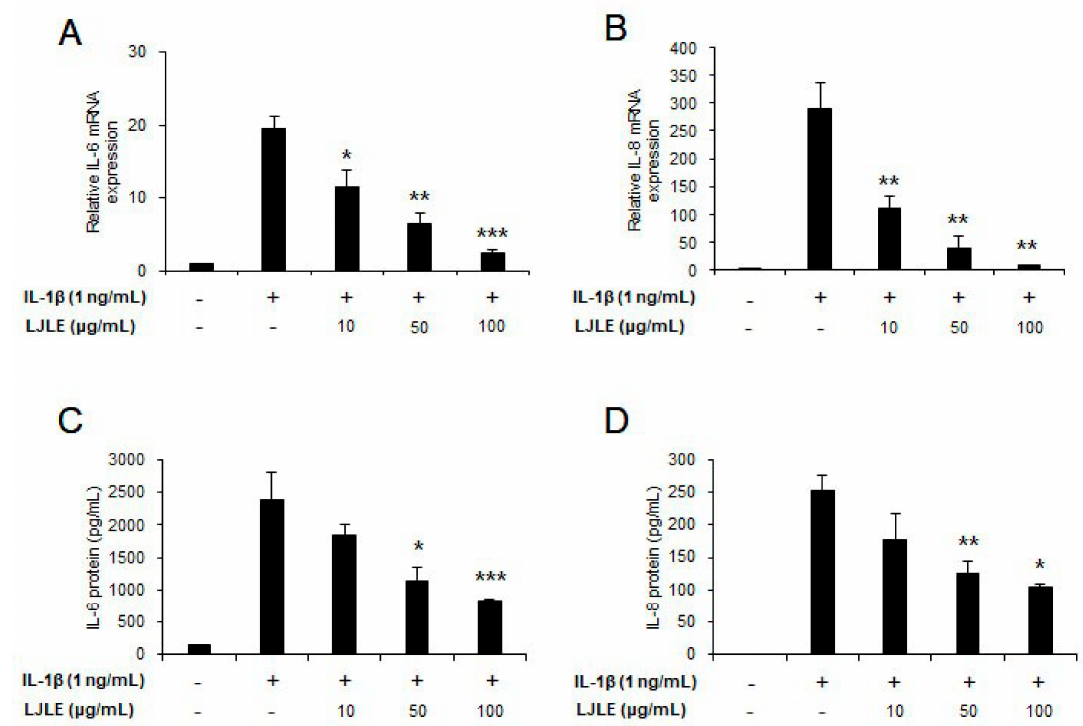
Figure 7. LJLE suppresses pro-inflammatory cytokine expression production in IL-1 β -stimulated human PDLFs. Human PDLFs were treated for 12 h with 0, 10, 50, or 100 μ g/mL LJLE in the absence or presence of 10 ng/mL IL-1 β . Concentration-dependent enhancing effects of LJLE on IL-6 and IL-8 ( A , B ) mRNA and ( C , D ) protein in IL-1 β -stimulated human PDLFs. * p < 0.05, ** p < 0.01, *** p < 0.001, and NS: Not significant compared with IL-1 β alone (unpaired two-tailed Student’s t -test).